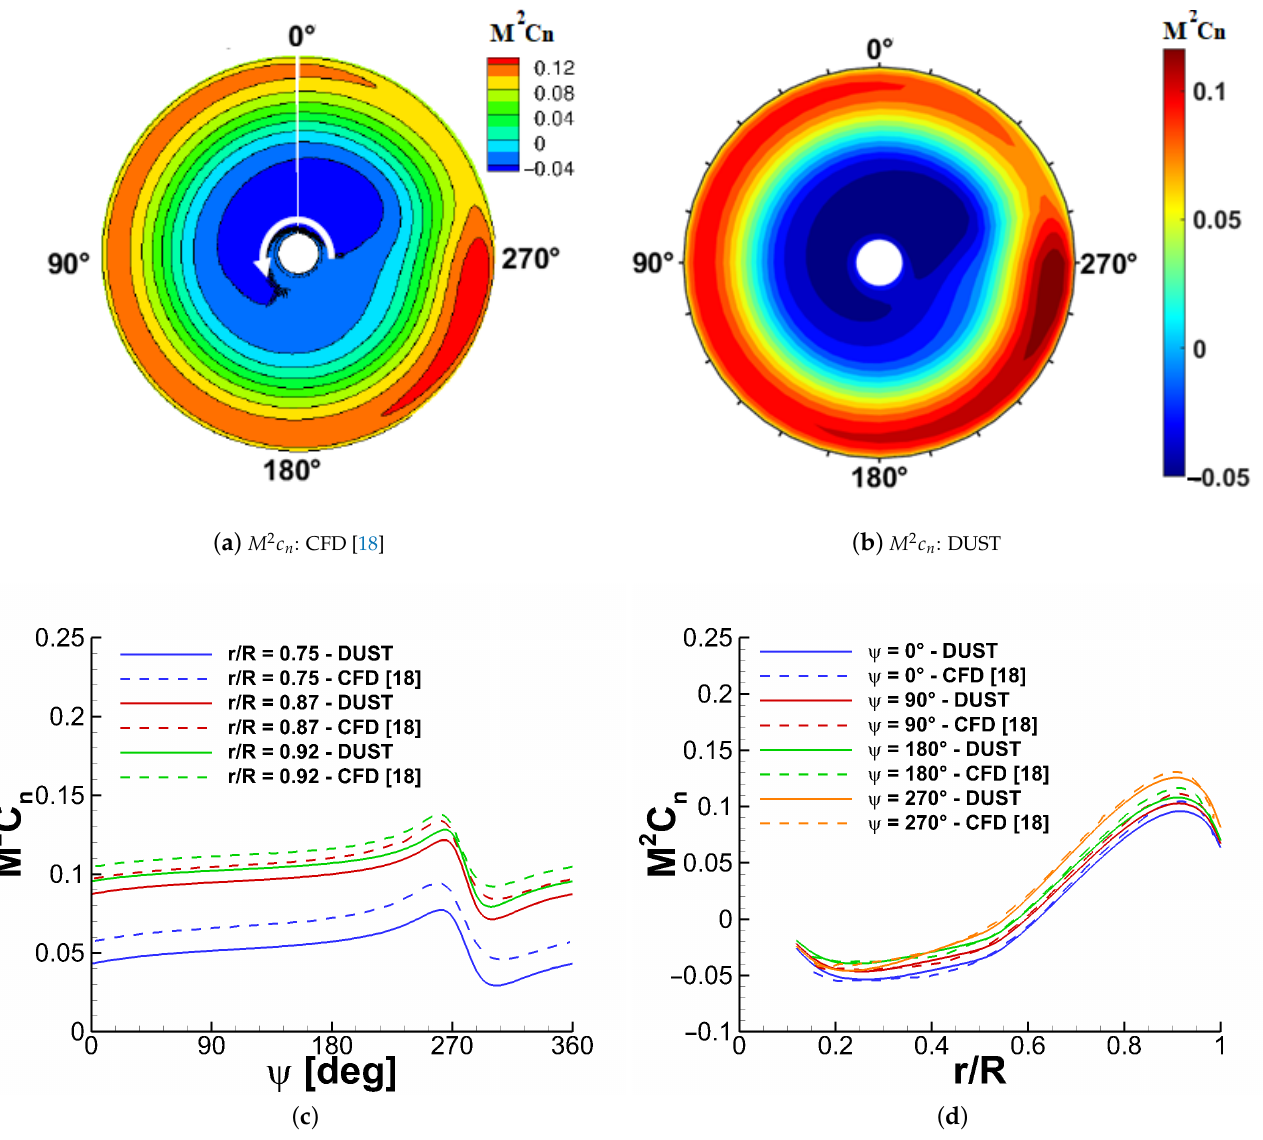
Figure 9. Comparison of the non-dimensional normal force M 2 c n on the proprotor blade, α = 5 ◦ , V ∞ = 220 kts, Ω = 517 RPM: ( a ) contour plot for CFD [18]; ( b ) contour plot for DUST; ( c ) time history; ( d ) radial